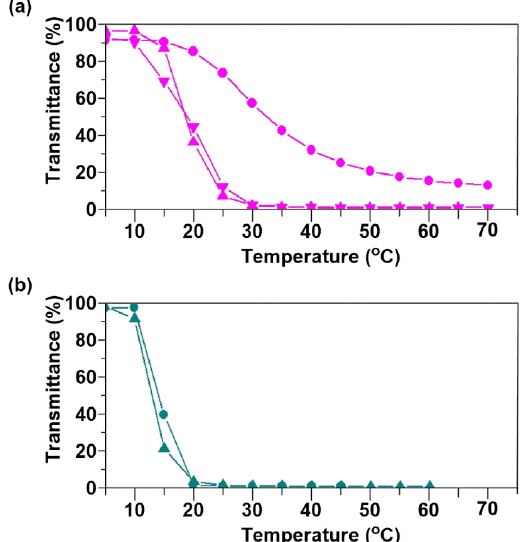
Figure5. Temperature-dependentopticaltransmittanceoftheaqueoussolutionsofpoly(DEGV- alt -EtMI) obtained using ( a ) CPDB ( • ; entry 1, (cid:72) ; entry 2 and (cid:78) ; entry 3 in Table 2) and ( b ) 1-dodecanethiol ( • ; entry 4 and (cid:78) ; entry 5 in Table 2) (concentration of polymers = 0.1 wt